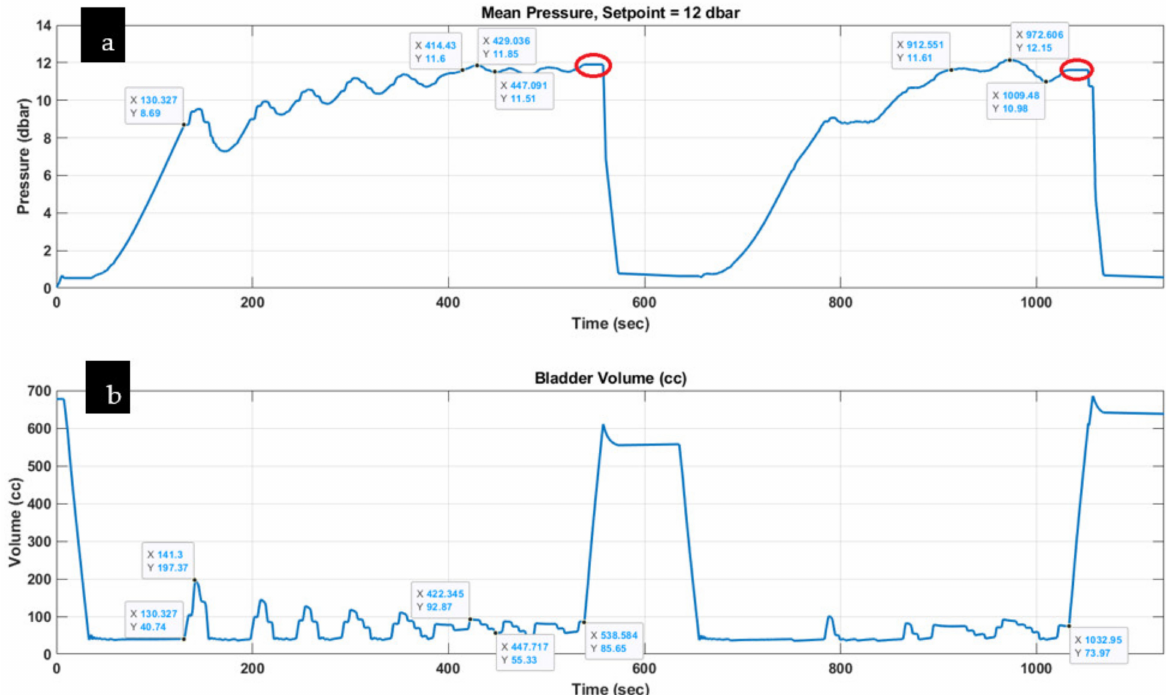
Figure 20. Sea trial deployment #2: ( a ) hydrostatic pressure reading; ( b ) bladder